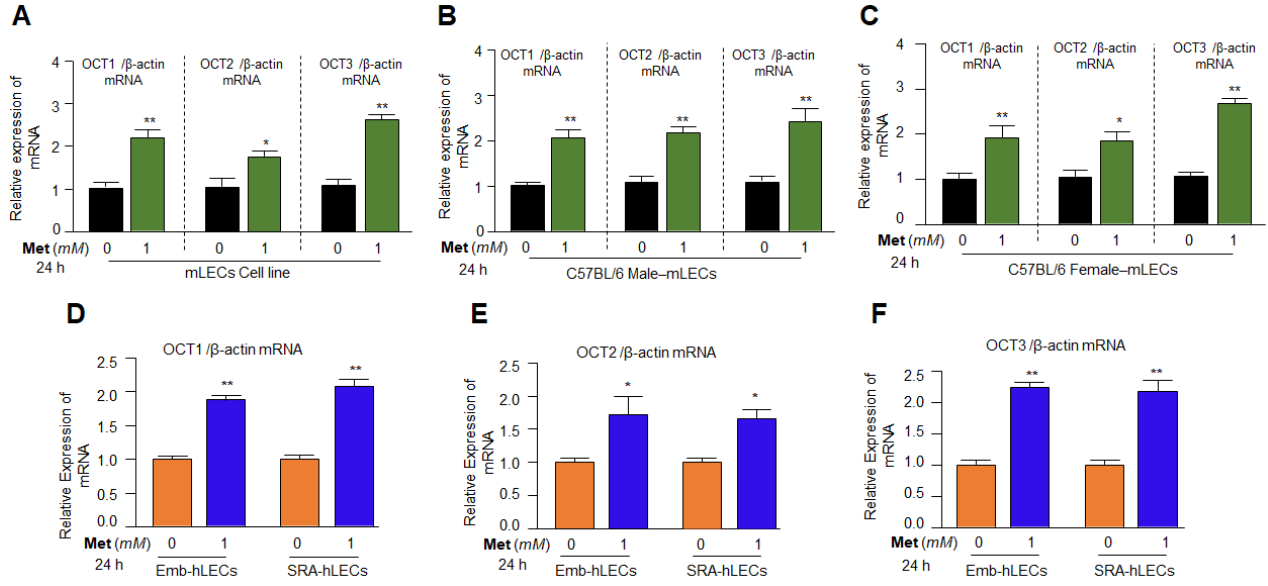
Figure 4. Organic Cation Transporters (OCTs) present in LECs of mouse and human and Metformin upregulated the expression of OCT1, OCT2 and OCT3 in mouse LECs of both sexes and human LECs. mLECs ( A ; 5 × 10 5 /60 mm), primary mLECs (5 × 10 4 /12-well plate) isolated from C57BL/6 male ( B ), or female mouse ( C ), Emb-hLECs ( D‒F ; 4 × 10 4 /12 well plate) or SRA- hLECs (D‒ F ; 5 × 10 5 /60 mm) were cultured and treated or untreated with 1 mM of Metformin for 24 h as shown. Total RNA was isolated and subjected for RT-qPCR and Western analyses with specific probes to OCTs. OCT1, OCT2 and OCT3 transcripts were significantly increased in response to Metformin. The histograms represent the mean ± S.D. from four independent experiments. Untreated vs. Metformin-treated; * p < 0.05; ** p < 0.001.